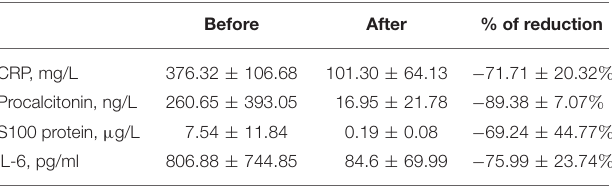
TABLE 4 | Plasma concentrations of CRP, procalcitonin, S100 protein, and IL-6 before and after blood purification procedure (mean ± SD, n = 4). Before